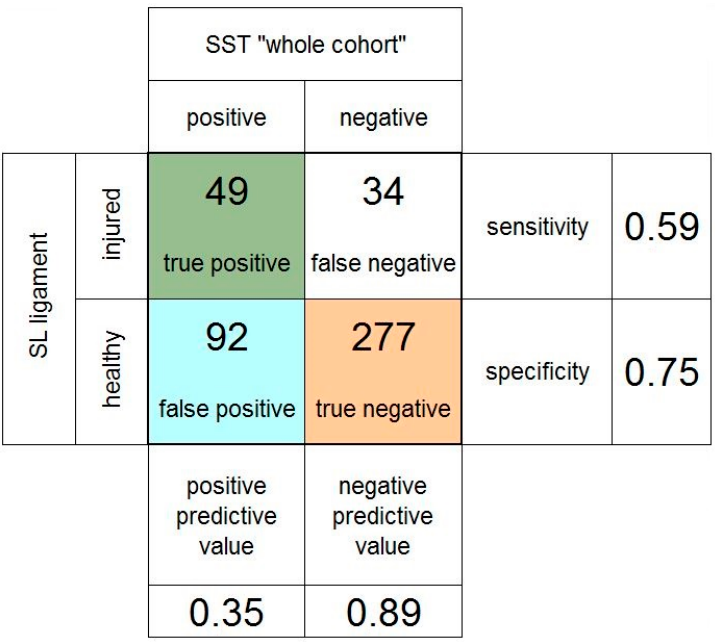
Figure 8. Fourfold table of the scaphoid shift test (SST) in the whole cohort of patients with static scapholunate (SL) ligament lesions defined as “SL ligament injured”, while no lesions or dynamic lesions during the arthroscopy were defined as “SL ligament healthy”.